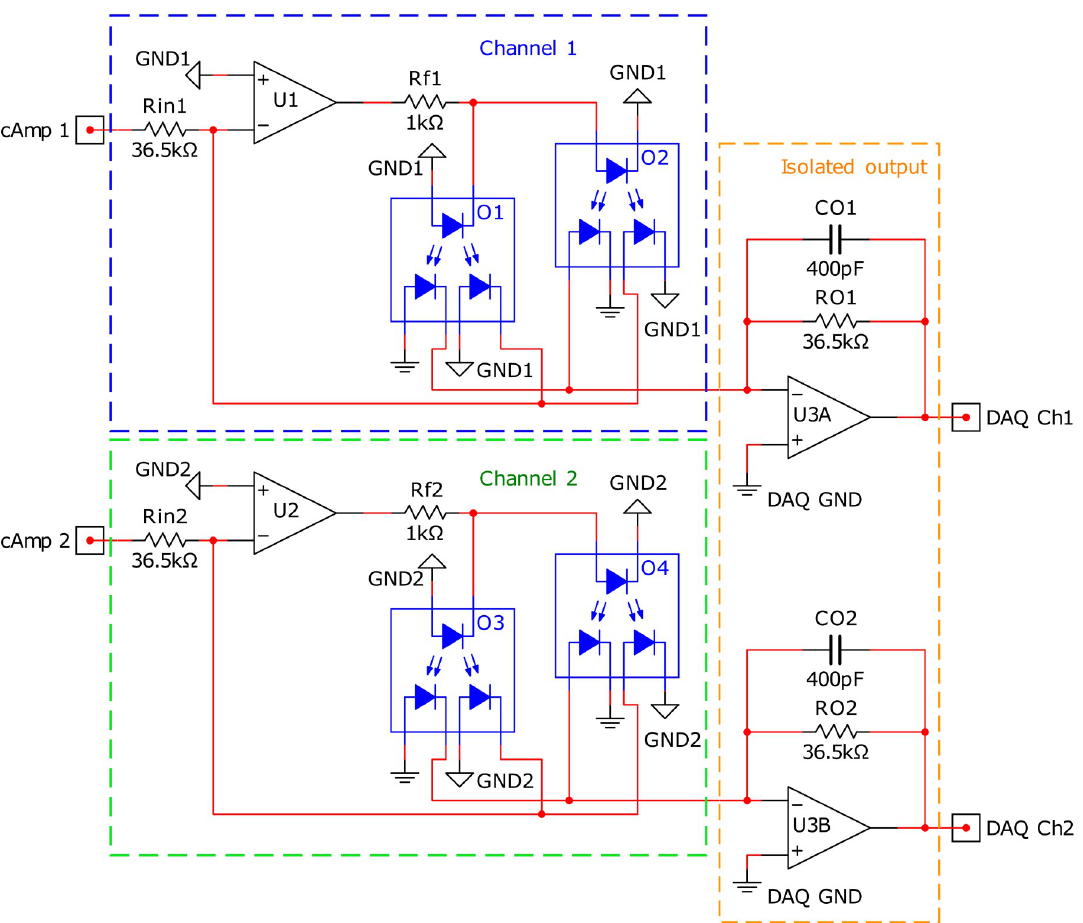
Fig 1. Schematic of the isolation module. The blue, green, and orange outlines mark the sections for channel 1, channel 2, and the common isolated output, respectively.